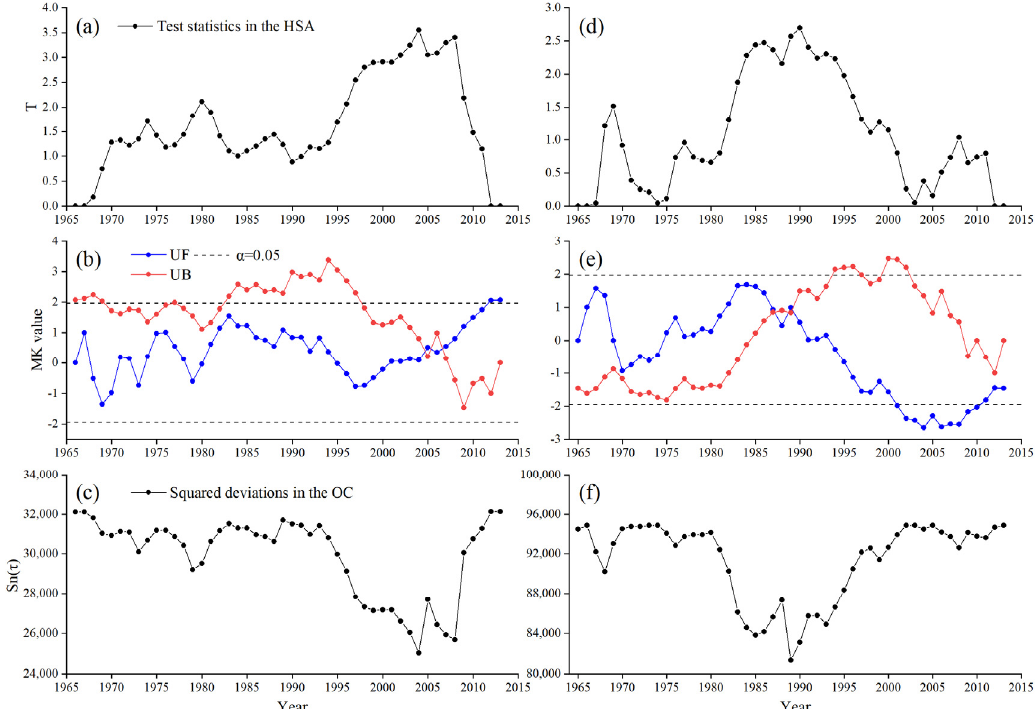
Figure 6. Result of the heuristic segmentation algorithm (HSA), Mann–Kendall (MK), and ordinal cluster (OC) mutation test of the annual runoff series in the SRYZ ( a – c ) and SRYR ( d – f ) (T represents the test statistics in the HSA method; Sn( τ ) represents the squared deviations in the OC